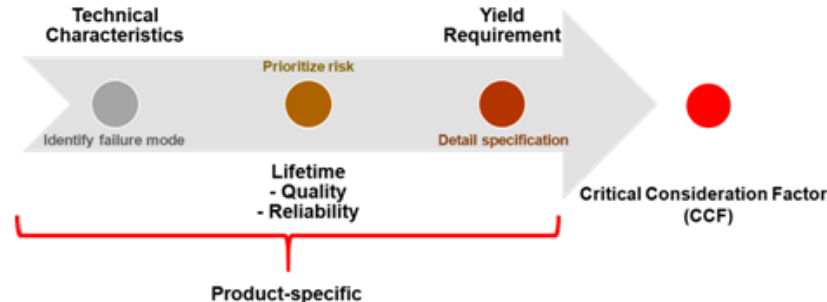
Figure 9. Elements of critical consideration